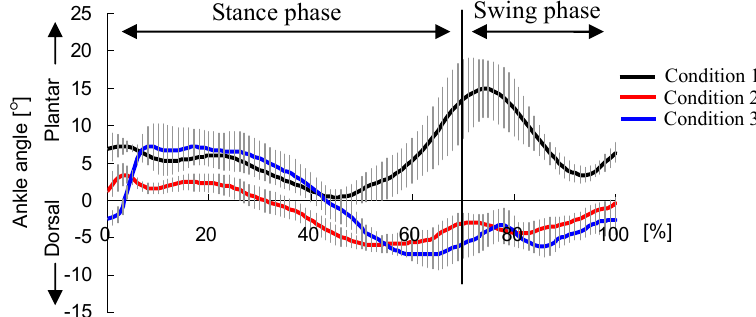
Fig. 7 Joint angle patterns of the affected side ankle (mean value ± SD) during one cycle of walking from foot contact to foot contact under each condition. The boundary between stance and swing phases is drawn using the mean value for all trials.